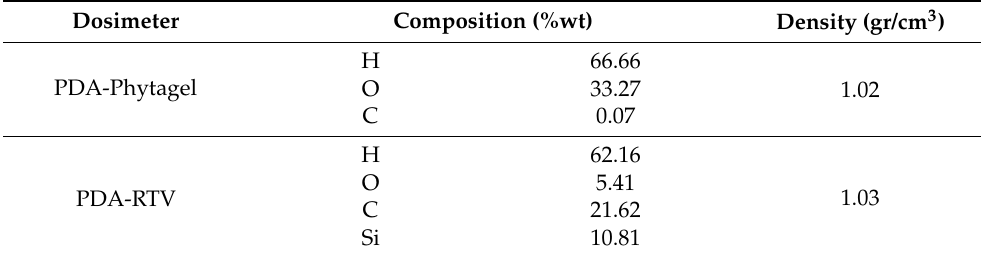
Table 1. Molecular weight of the composition of PDA-Phytagel and PDA-RTV.